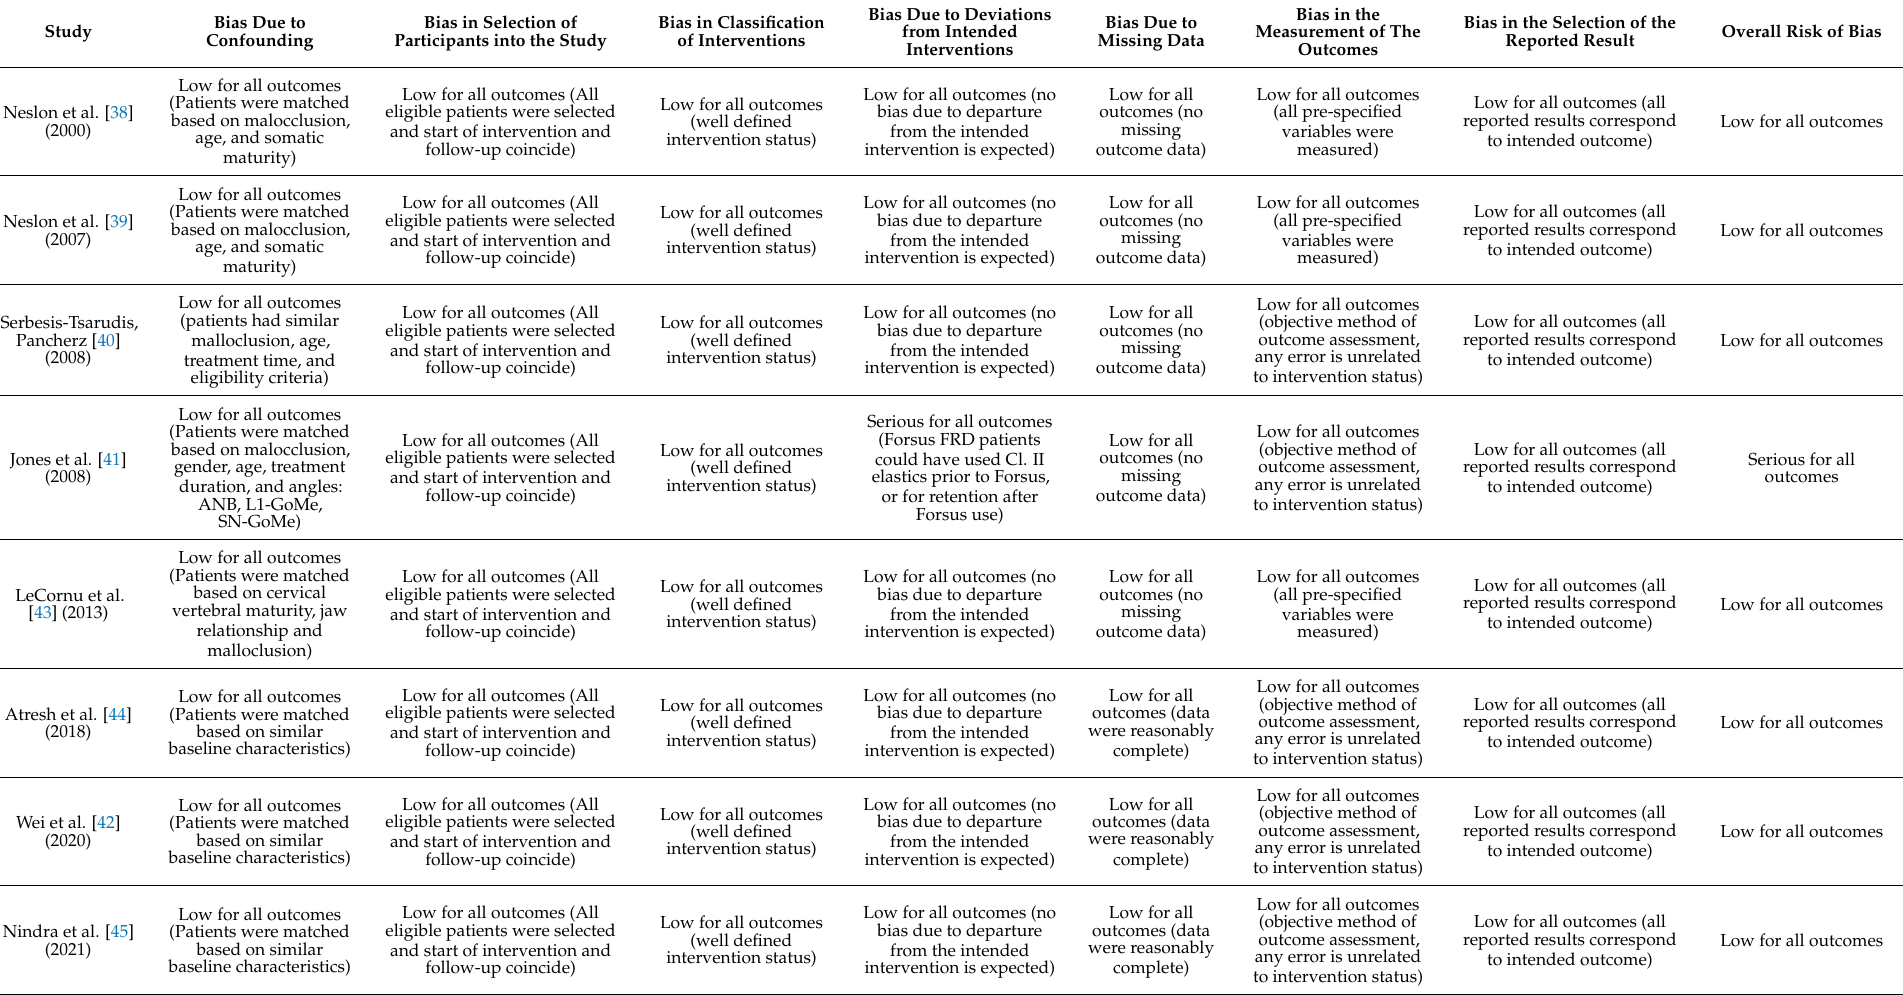
Table 3. Risk of bias assessment for non-randomized studies of